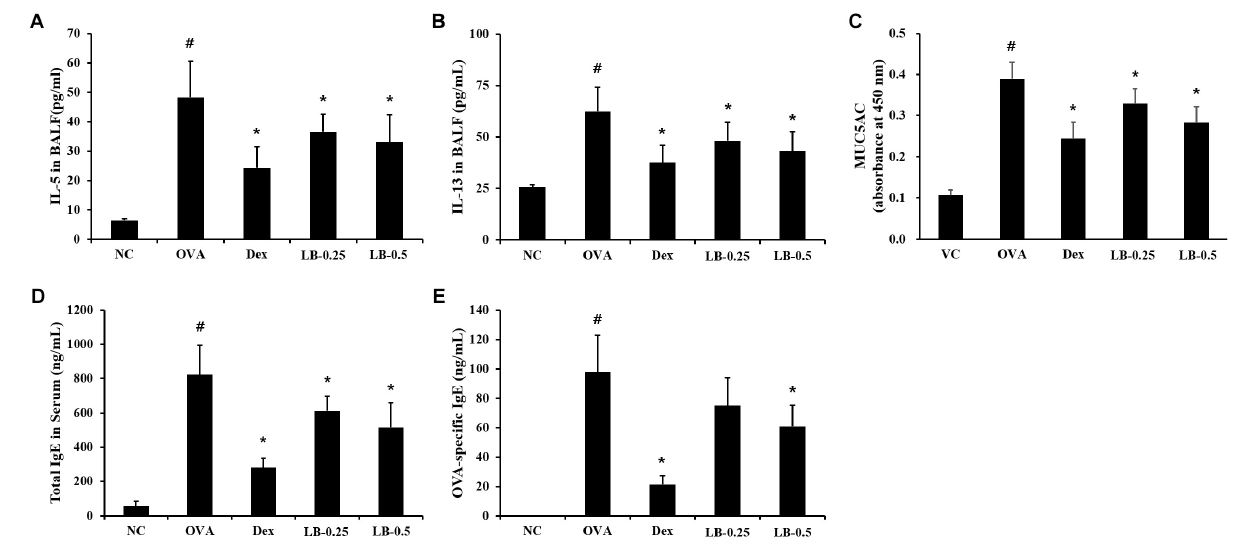
FIGURE 3 | Effects of lobeglitazone (LB) on IL-5, IL-13, and MUC5AC levels in BALF and total IgE and OVA-specific IgE levels in serum from OVA-challenged animals. IL-5, MUC5AC, total IgE, and OVA-specific IgE levels were determined using ELISA Kit. (A) IL-5 in BALF, (B) IL-13 in BALF, (C) MUC5AC in BALF, (D) Total IgE in serum, (E) OVA-specific IgE. NC, normal control mice; OVA, OVA-sensitized/challenged mice; Dex, dexamethasone (3 mg/kg) + OVA-sensitized/challenged mice; LB-0.25 and –0.5, LB (250 µ g/kg or 500 µ g/kg, respectively) + OVA-sensitized/challenged mice. Values are expressed as mean ± SD ( n = 6/group). # Significantly different from NC, P < 0.05. ∗ Significantly different from OVA, P <